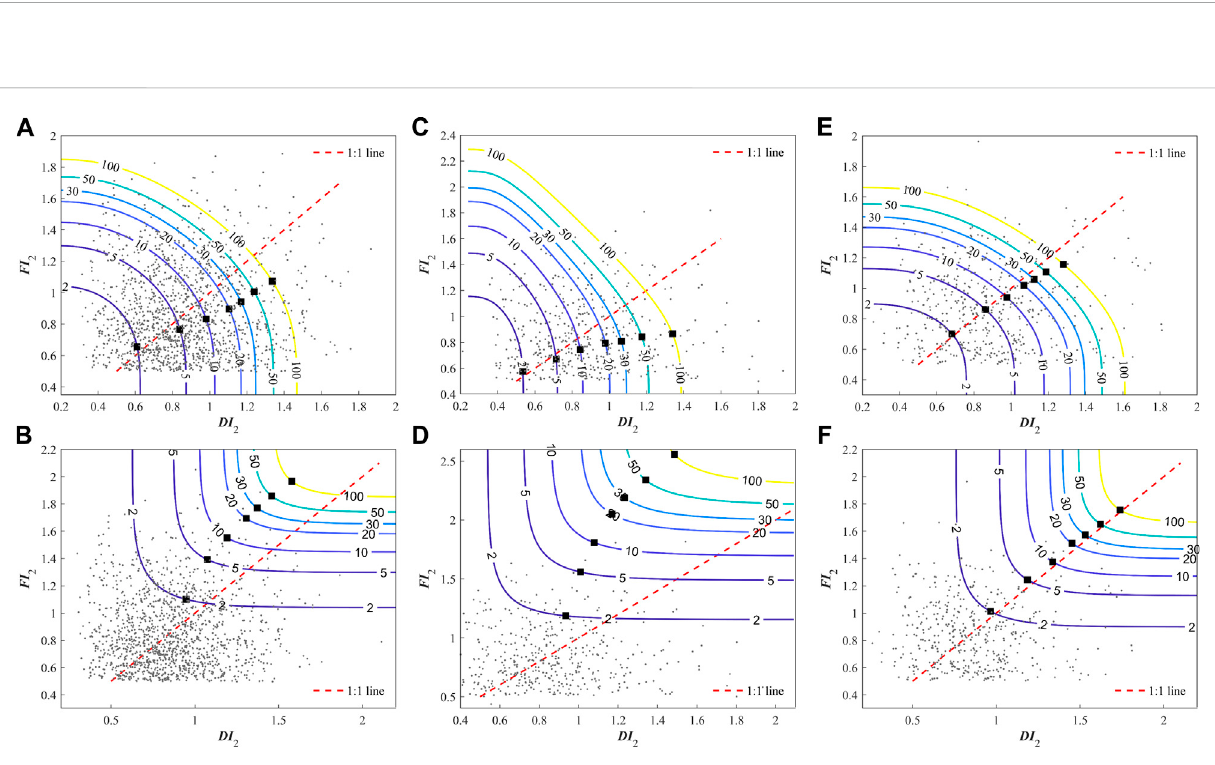
FIGURE 12 Isolines and MLCs of DI 2 and FI 2 for three sub-basins in the HRB. The squares denote MLC ( di *, fi *) while the small black dots are the identi fi ed DTF events: (A) The AND case in UB; (B) The OR case in UB; (C) The AND case in MB; (D) The OR case in MB; (E) The AND case in LB; (F) The OR case in